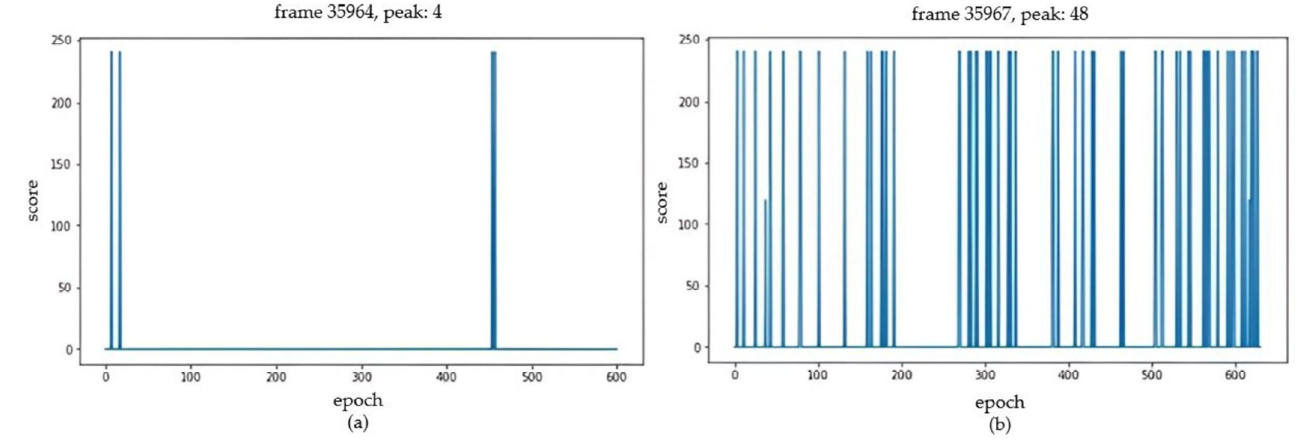
Figure 10. Placement task behavior clone training. ( a ) Training process using 10 data. ( b ) Training process using 20 data.